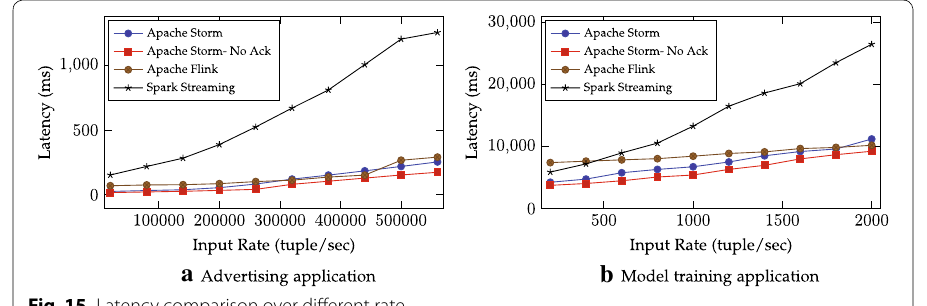
Fig. 15 Latency comparison over different